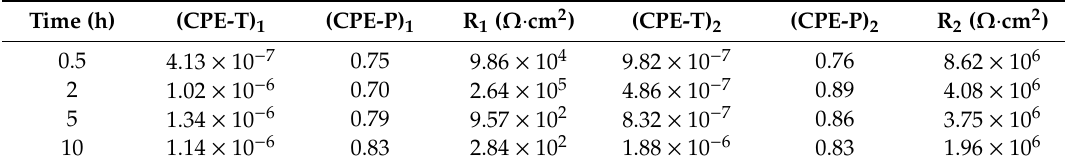
Table 2. EIS-fitting results for MAO coating on AZ31 alloy after immersion in 0.1 M NaCl solution for di ff erent times.